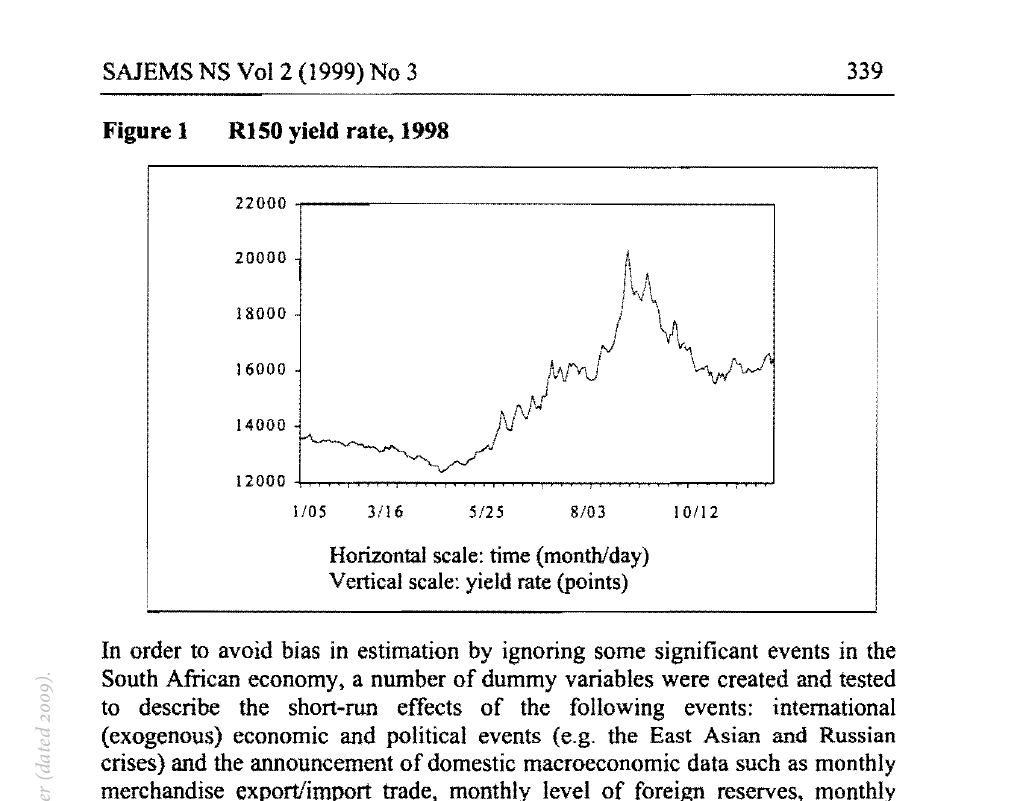
Horizontal scale: time (month/day) Vertical scale: yield rate